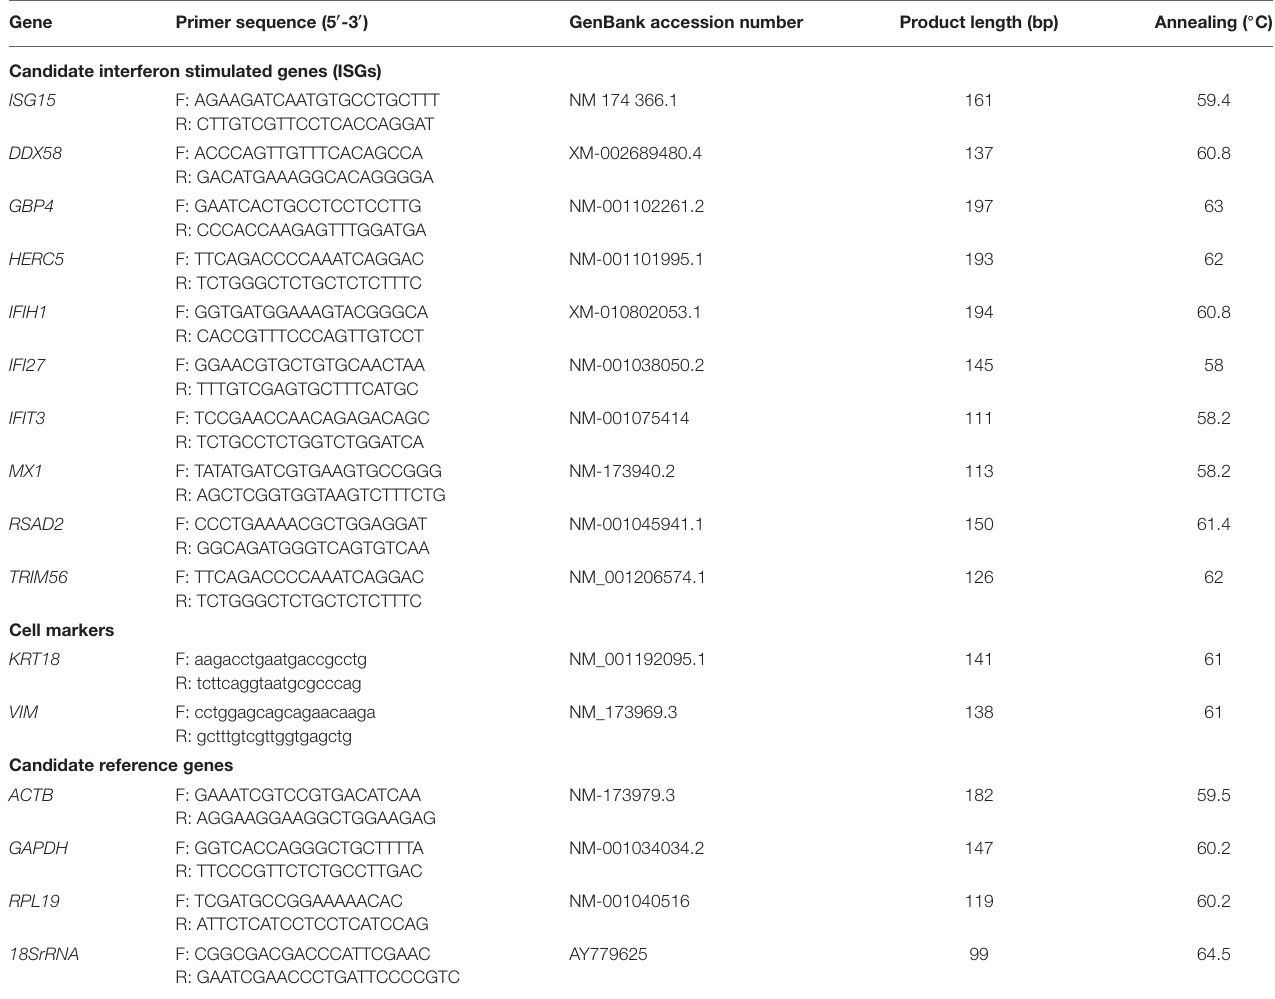
TABLE 1 | Primer sequence information for qPCR. Gene Primer sequence (5 ′ -3 ′